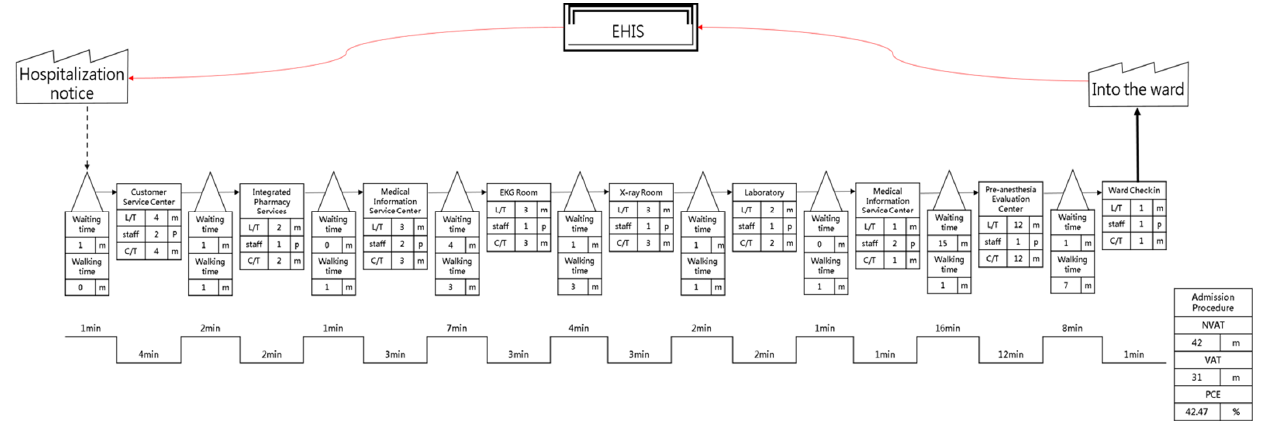
Figure 6. Future value flow chart for the hospital admission procedure.